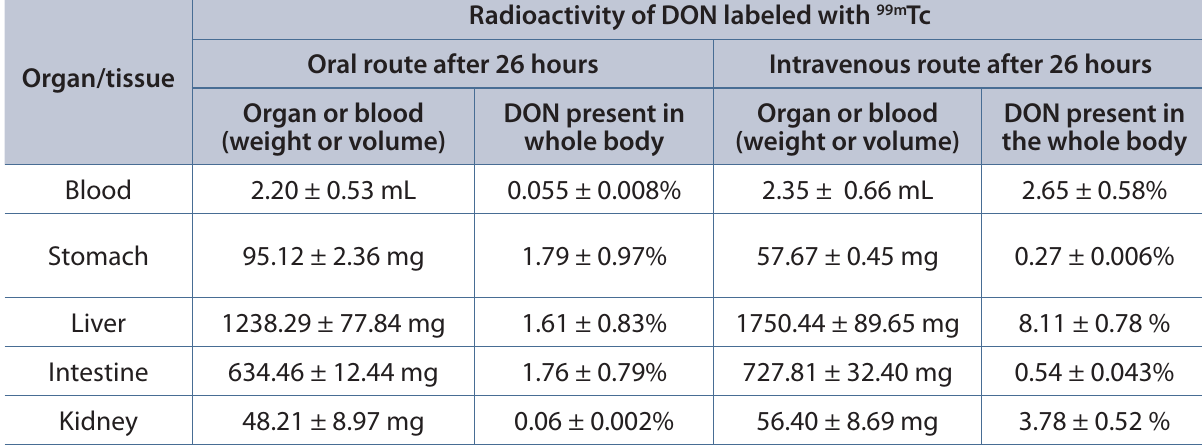
Table 1. Biodistribution of 99m Tc -labeled DON Organ/tissue